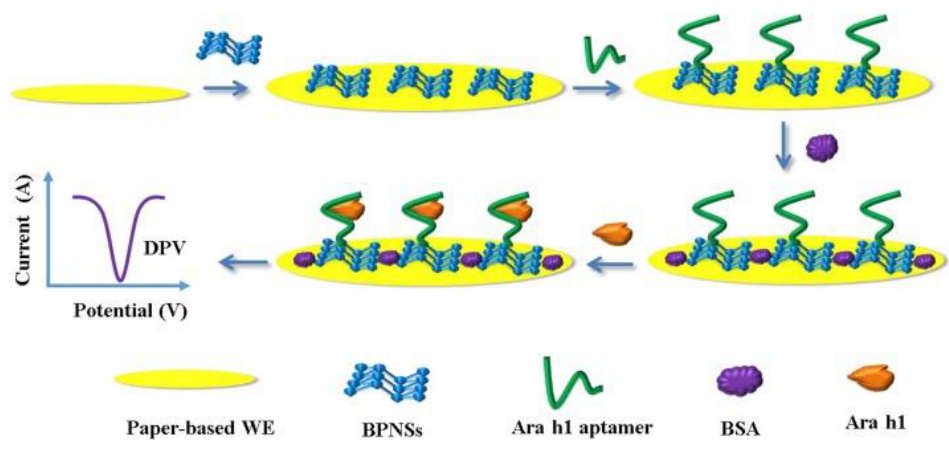
Figure 13. A schematic illustration of the aptamer sensing mechanism of the microfluidic origami electrochemical aptasensor. Reprinted with permission from [145]. Copyright 2021, Elsevier.